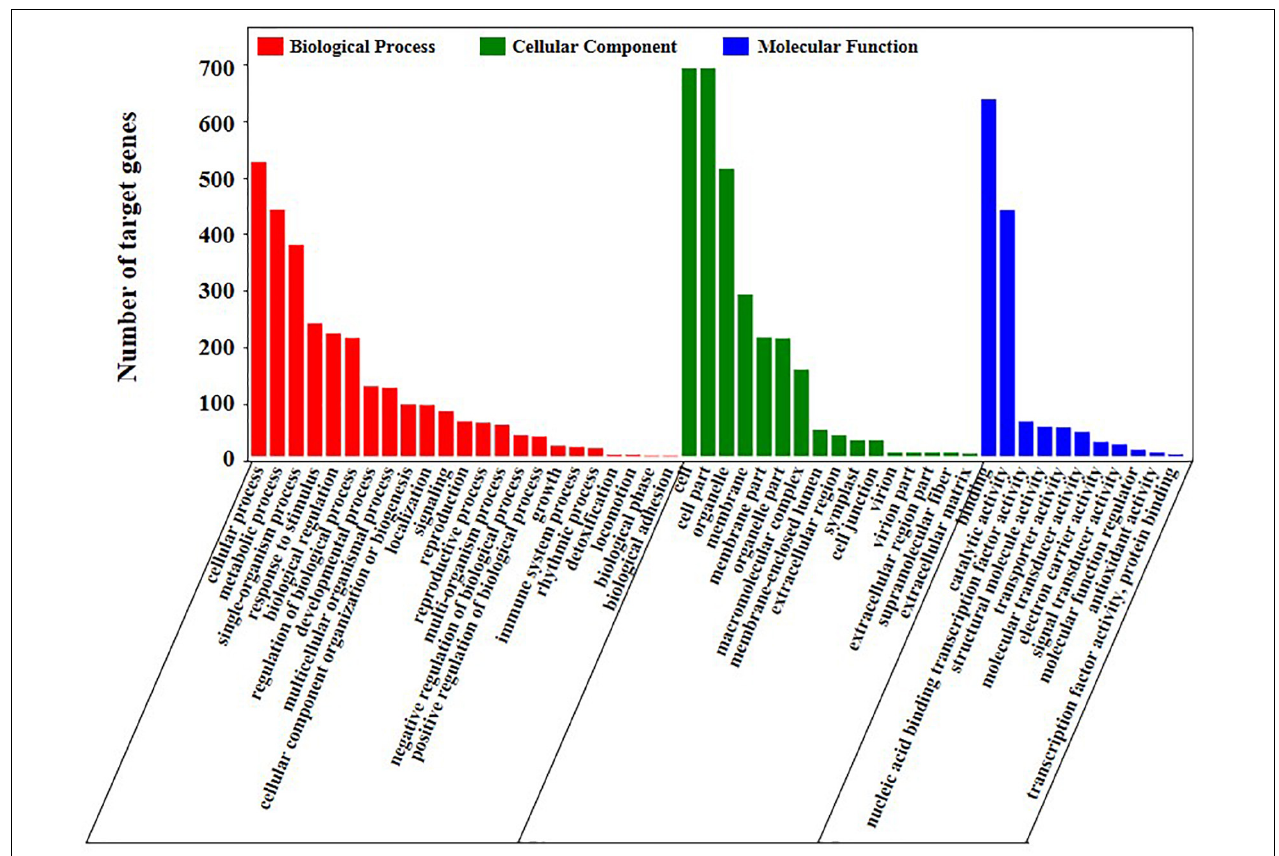
FIGURE 6 | GO analysis of the target genes of differentially expressed miRNAs in genotype and salt stress